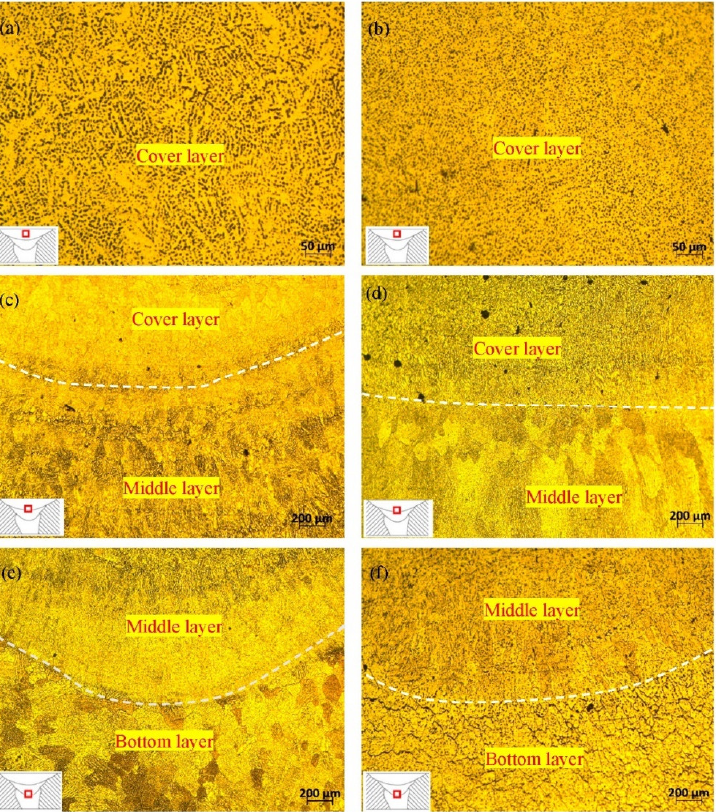
Figure 4. The metallographic structures of the weld zones in ER5356 and ER5087 welded joints, ( a ) the cover layer of ER5356 welded joint, ( b ) the cover layer of the ER5087 welded joint, ( c ) the interface between the cover and bottom layers of the ER5356 welded joint, ( d ) the interface between the cover and middle layers of the ER5087 welded joint, ( e ) the interface between the middle and bottom layers of the ER5356 welded joint, and ( f ) the interface between the middle and bottom layers of the ER5087 welded